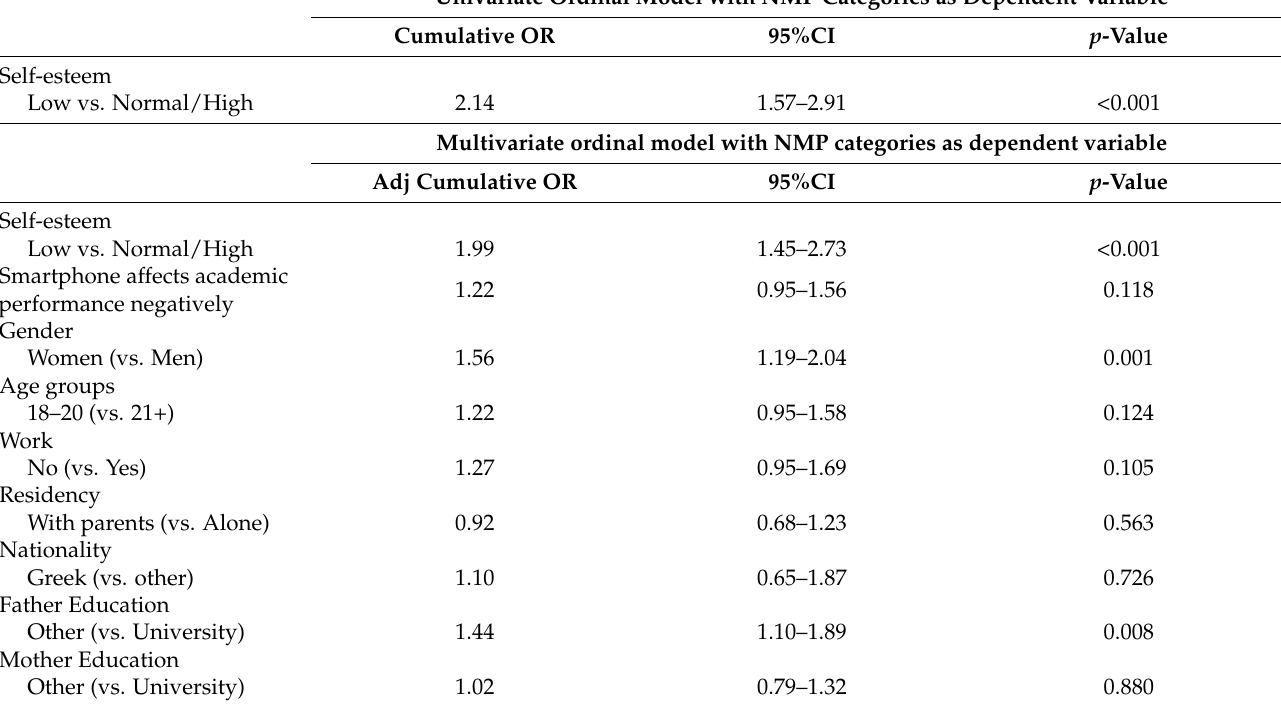
Table 4. Cumulative odds ratios derived from ordinal logistic regressions with NMP categories as dependent